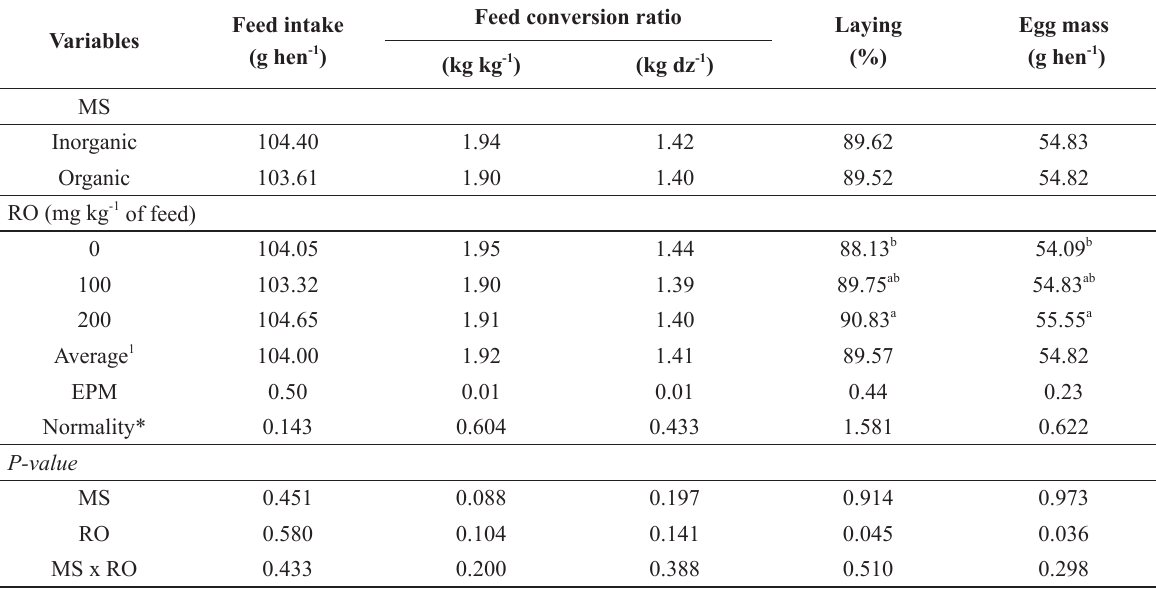
Performance of red layers fed different mineral sources (MS) and rosemary oil levels